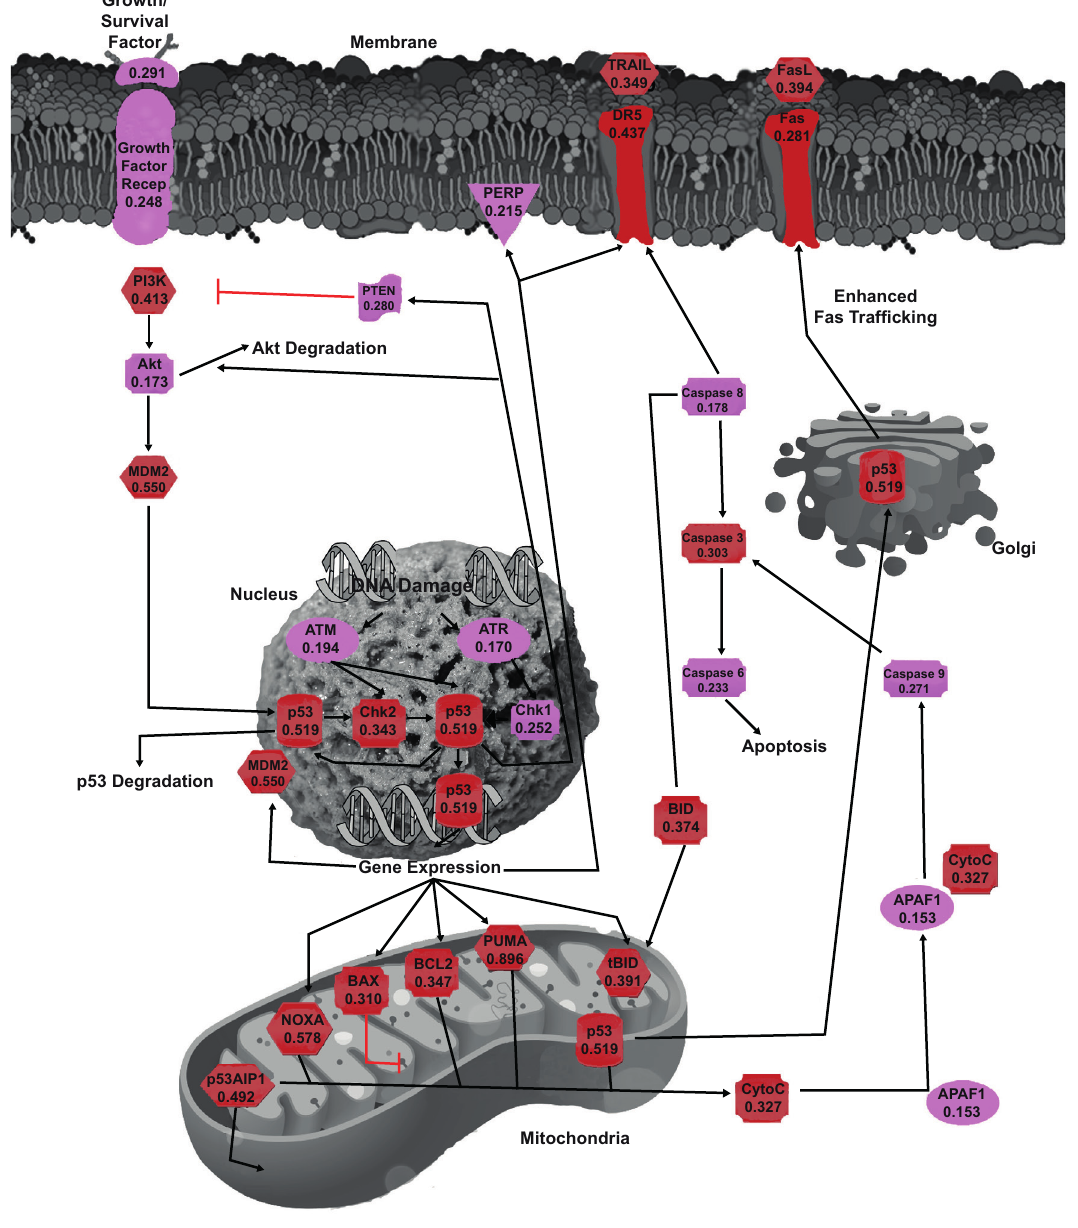
Figure 2. Schematic representation of the p53-mediated apoptotic signaling pathways. Diagram shows a map of the regulators and molecular components of this pathway. The proteins are color coded according to their intrinsic disorder content evaluated by PONDR-FIT, with highly ordered ([IDP score]<10%), moderately disordered (10% ≤ [IDP score]<30%), and highly disordered ([IDP score] ≥ 30%) being shown as blue, pink, and red boxes, respectively. This diagram is based on the maps of the p53-mediated apoptotic signaling